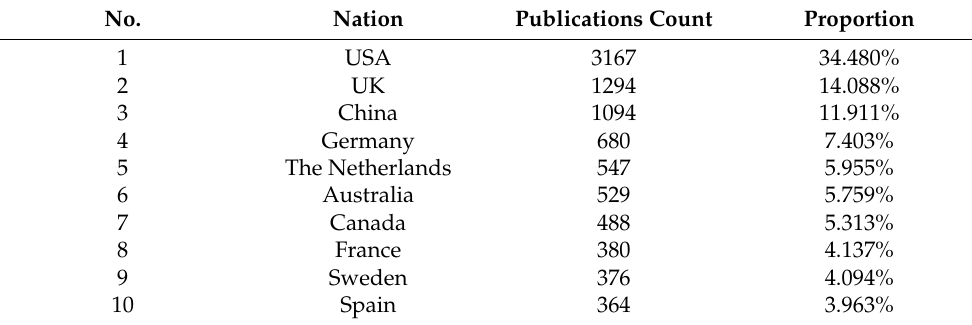
Table 1. Most contributing nations in research on environmental regulation from 2000 to 2019. No. Nation